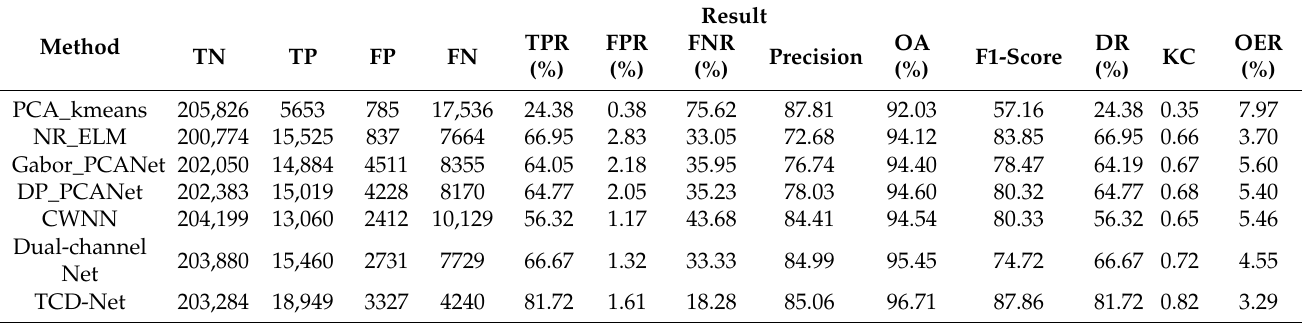
Table 7. The accuracy of different change detection methods for